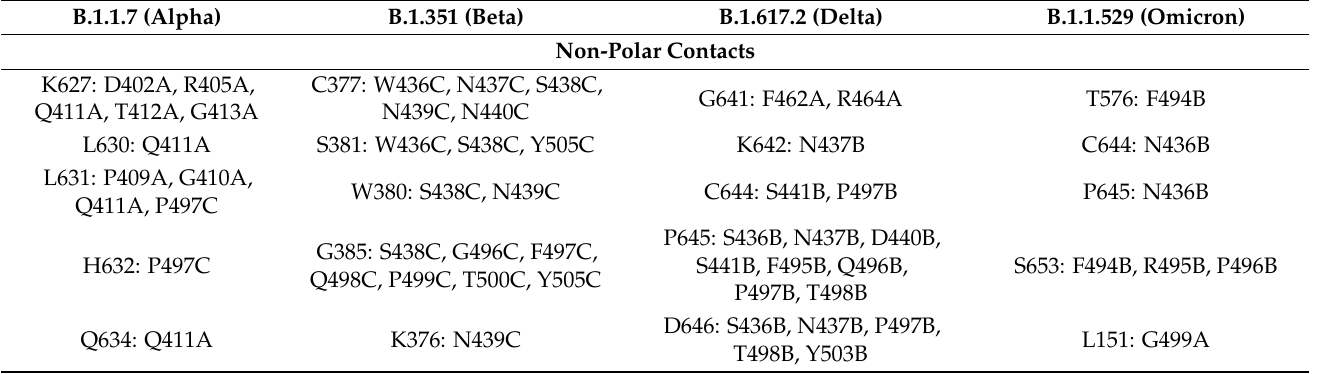
Table 5. Non-polar interactions established between the bovine lactoferrin and the Spike glycoprotein surface (chain A, B or C), calculated for the four variants of concern. Only interactions identified for more than 40% of simulation time are